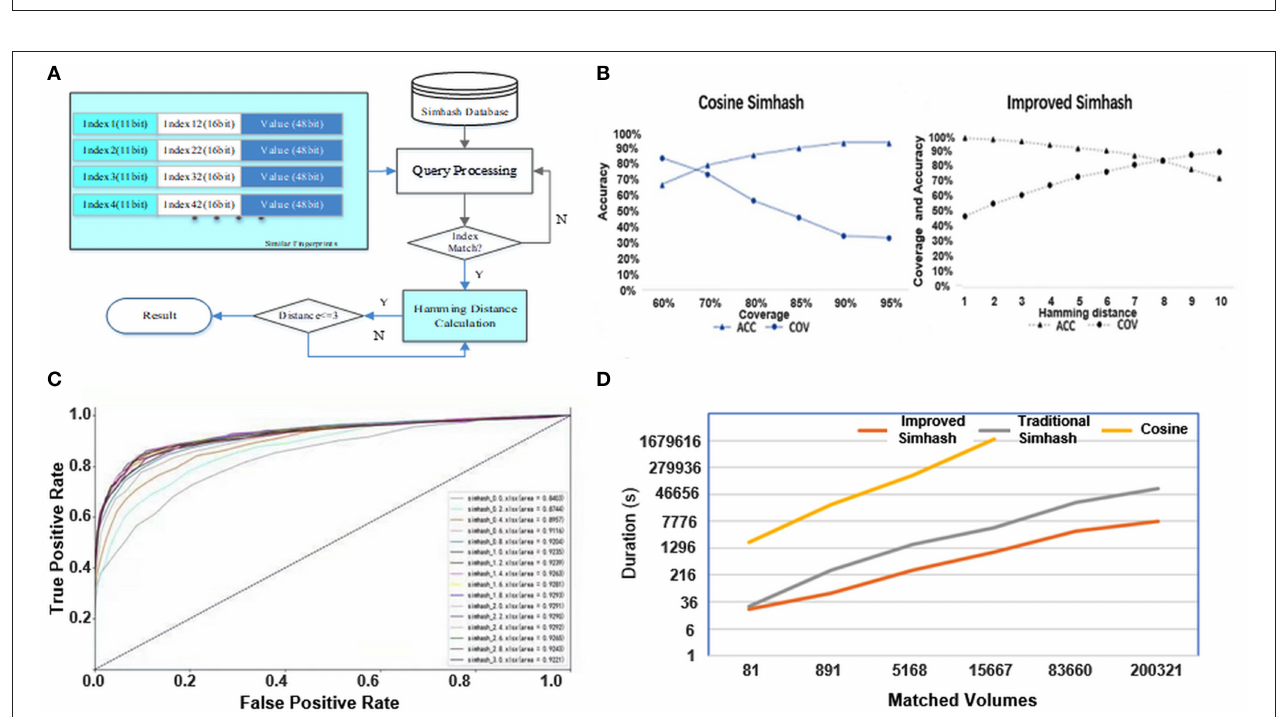
FIGURE 3 | (A) Hierarchical index architecture. (B) Algorithm performance evaluation . (C) Influence of parameter change on ROC curve. (D) Efficiency comparison of different